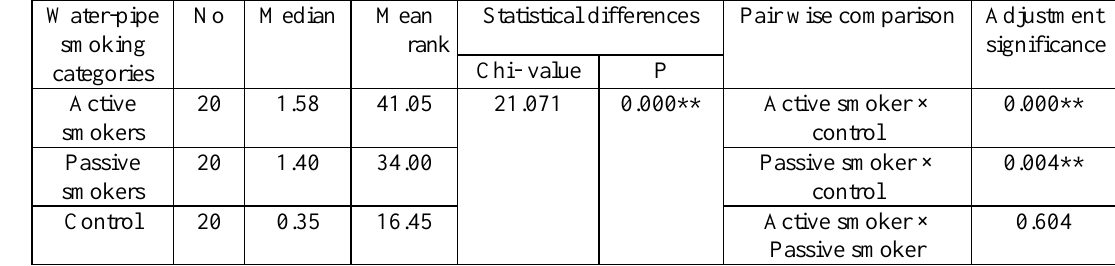
Table 1: plaque index (Median, Mean Rank) among water-pipe smokers in comparison to control group.